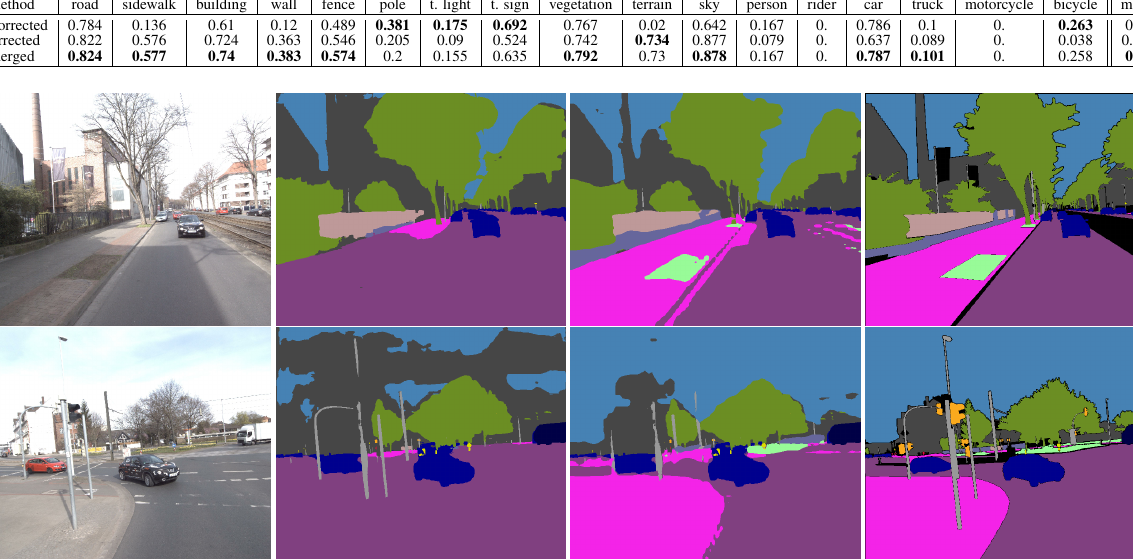
Table 1. The table shows the results of the pre-trained DCNN (uncorrected), the retrained DCNN (corrected) and the merged results (merged). The best results per class are shown in bold.